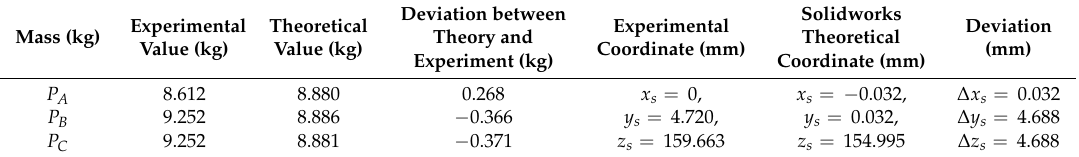
Figure 5. Standard workpiece mass data at three points. Table 8. The comparison of the centroid of the standard workpiece between simulation and experimental results.